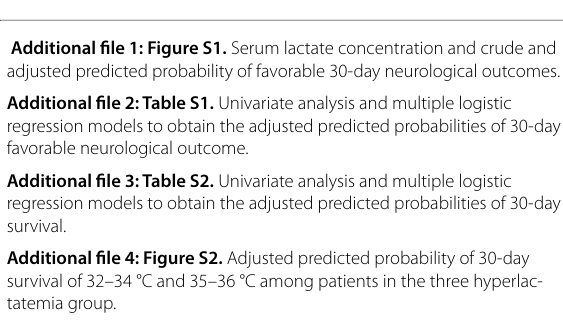
Supplementary information accompanies this paper at https ://doi. org/10.1186/s1361 3-019-0603-y.